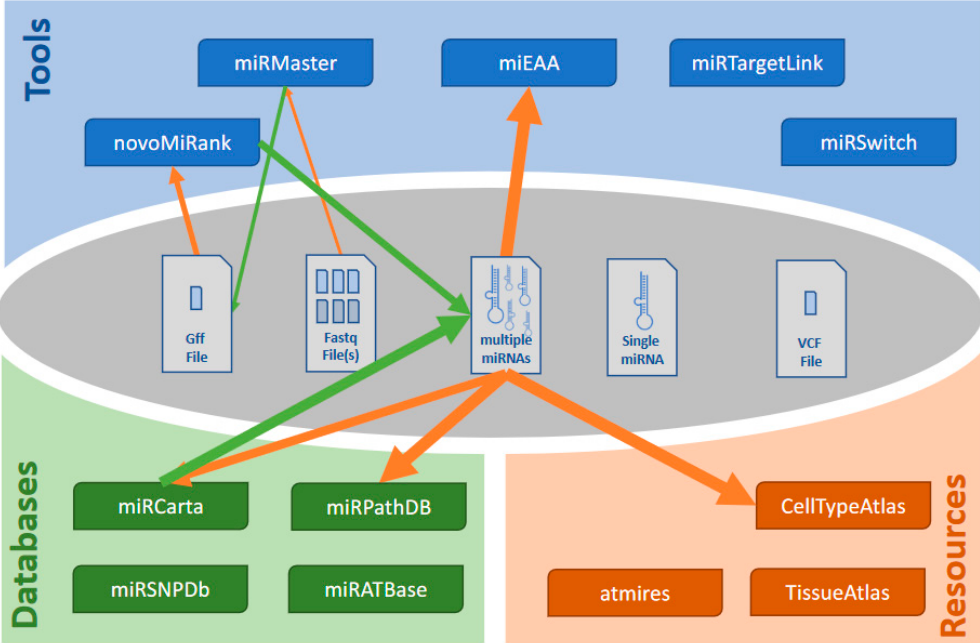
Figure 2. One walk and workflow. Taking the setup from Figure 1, an example workflow is presented. The thickness of the arrow represents the steps in the workflow. Starting from a fastq file miRMaster is used to predict new miRNAs. From these new miRNAs a *.gff file is extracted and used to score the most likely true positive miRNAs. Those most likely true positive miRNAs can be checked for consistency with miRCarta and the consistent miRNAs from miRCarta can then be checked with respect to their expression profiles, or target pathways can be evaluated. Pathway enrichment using miEAA is also evaluated. Table 1. Tool overview.